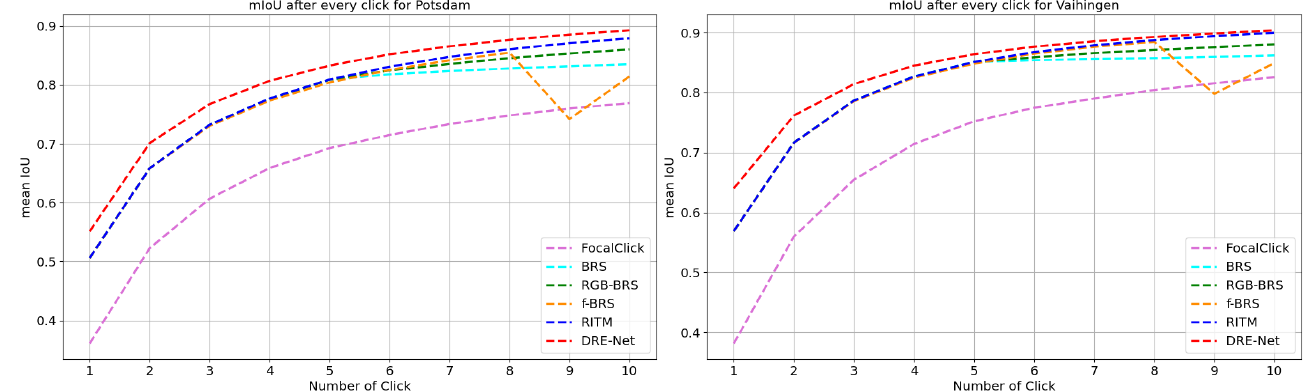
Figure 11. Mean IoU@k curves for the Potsdam dataset and Vaihingen dataset.